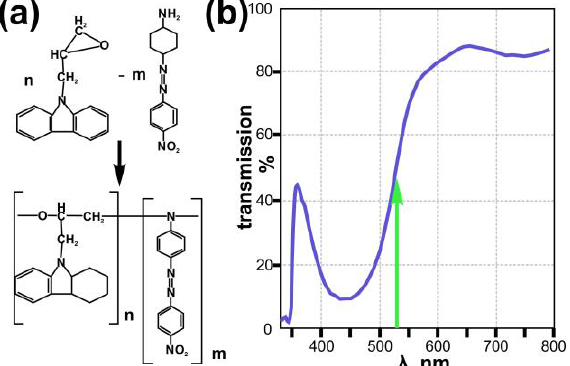
Figure 1. Scheme of synthesis and chemical structure of the used azopolymer EPC:DO3 ( a ) and the transmission spectra of the EPC:DO3 azopolymer film used in this study ( b ). Green arrow indicates wavelength of recording laser (532 nm) used in this study.